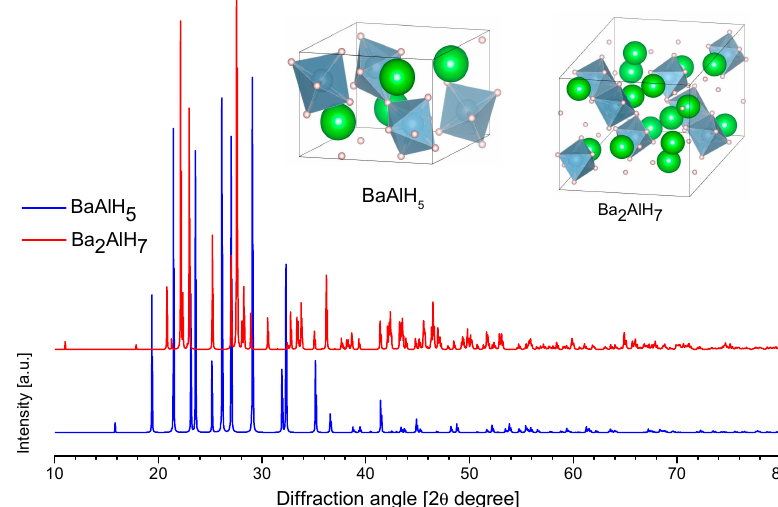
Figure 19. Crystal structure of barium alanates and their calculated diffraction patterns ( λ = Cu k α 1